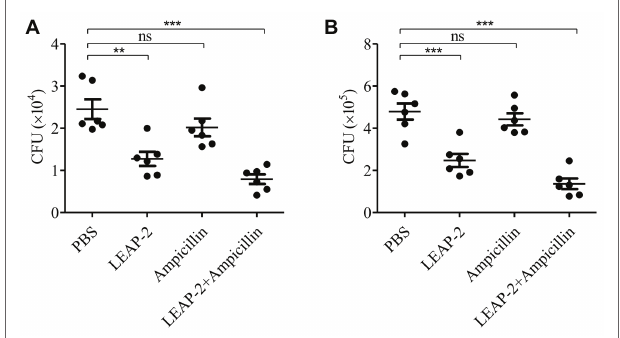
FIGURE 6 | Antimicrobial activity and combinational usage of topmouth culter LEAP-2 with ampicillin in vivo . (A) Topmouth culter (350–450 g, n = 6) were intraperitoneally challenged with A. hydrophila (100 μ l, 2 × 10 7 CFU/ml), and immediately intraperitoneally administrated with LEAP-2 (10 mg/kg), ampicillin (10 mg/kg), LEAP-2 and ampicillin used in combination (10 mg/kg each), or an equal volume of PBS (vehicle), respectively. At 8 h post infection, bacterial loads in the peritoneal lavage of topmouth culter were counted. (B) C57BL/6 mice (female, 18–20 g, n = 6) were intraperitoneally challenged with A. hydrophila (2 × 10 7 CFUs/mouse). Topmouth culter LEAP-2 (10 mg/kg) or an equal volume of PBS (vehicle) was intraperitoneally administered into mice post bacterial infection. At 18 h post infection, bacterial loads in the peritoneal lavage of mice were counted. ns, not significant, ** p < 0.01, *** p < 0.001.